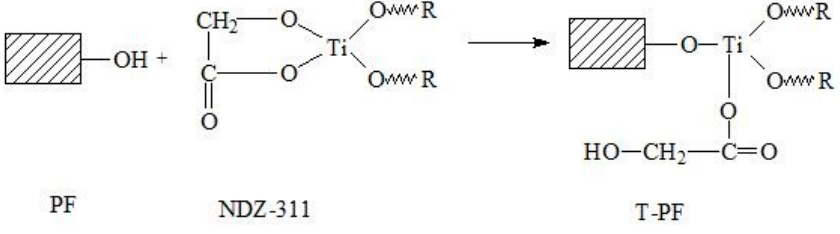
Figure 4. The coupling schematic of PF and titanate coupling agent